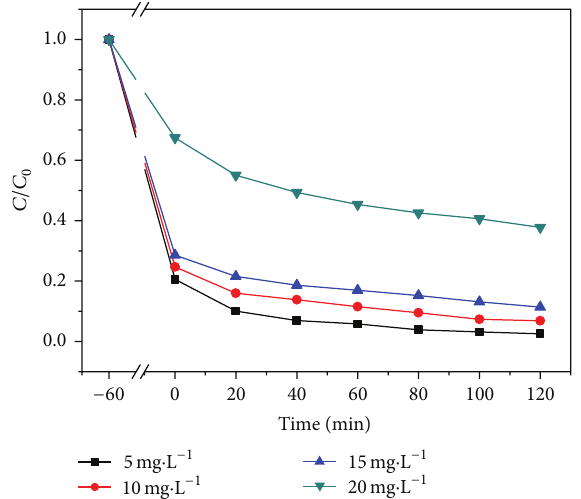
Figure 8: The effect of substrate concentration on the photocatalytic degradation